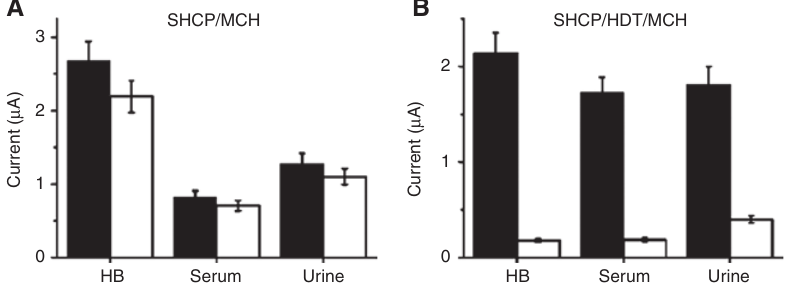
Figure 6: Antifouling properties of the SHCP/MCH electrode (A) and SHCP/HDT/MCH electrode (B) after 24 h in hybridisation buffer (HB), serum, and urine. Black columns represent response from 1 nm of target DNA and white columns represent blank response (0 nm of target DNA). Reproduced with permission from Kuralay et al.